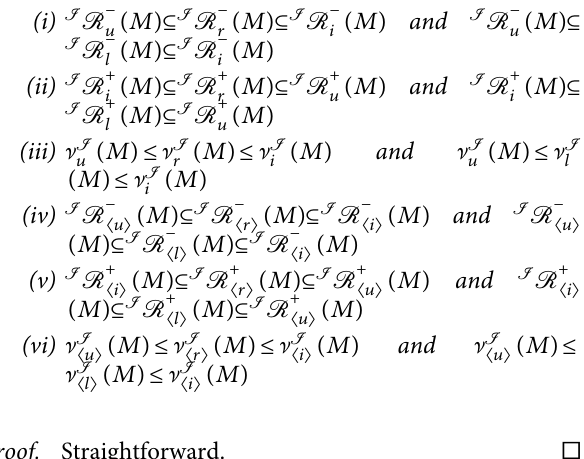
Table 4: Comparison between σ I M ⊆